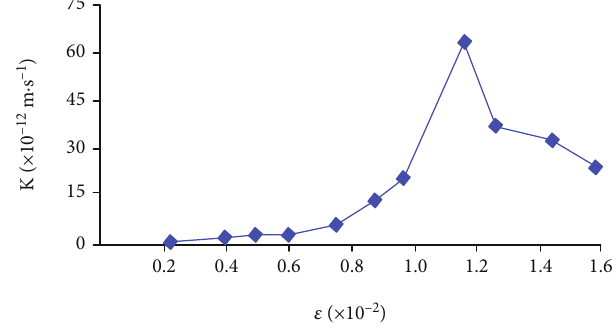
Figure 8: Variation curve of the permeability coe ffi cient K with strain ε .